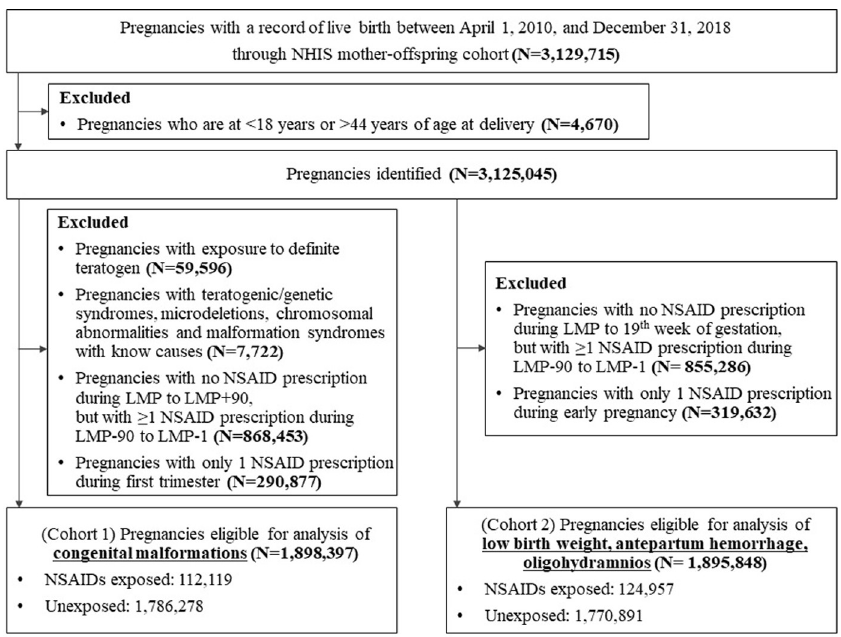
Fig 1. Study flow chart. LMP, last menstrual period; NHIS, National Health Insurance Service; NSAID, nonsteroidal anti-inflammatory drug. � First trimester is defined as the period between the LMP to LMP+90 (cohort 1). † Early pregnancy is defined as the period between LMP to 19 week of gestation (cohort